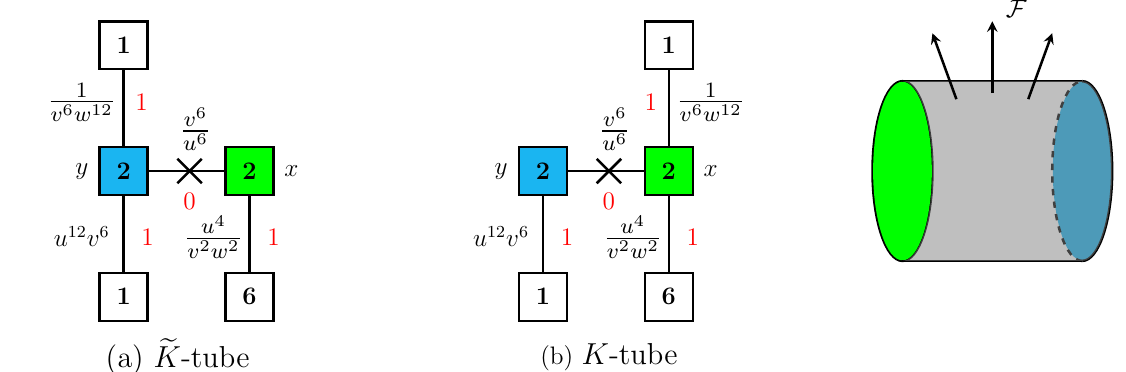
Figure 10: Quiver of the tube theories. In Figure (a) we show tube with the con- jugation with the index given (3.40). In Figure (b) we show tube theory with no conjugation and index given by (3.39). The theories differ only by singlets which are important once we start gluing these tubes to other